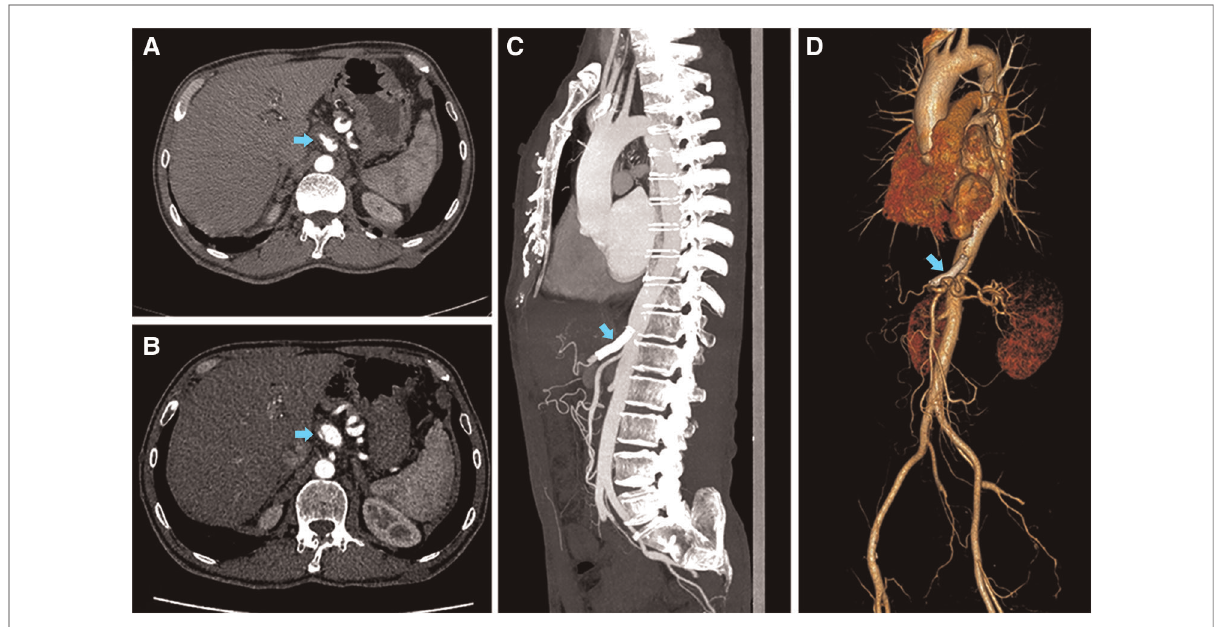
FIGURE 1 Imaging fi ndings of the therapeutic process for one patient for whom the conservative treatment failed. A 51-year-old Male with a complaint of abdominal pain for 1 day was diagnosed with symptomatic spontaneous isolated celiac artery dissection. ( A ) The imaging presented intramural hematoma accompanied by a penetrating ulcer. The patient was subjected to conservative treatment. ( B ) Three months after discharge, the patient had a symptomatic progression. The imaging showed the lesion had a severe extension with a visible dissection fl ap and narrow true lumen 3 months after discharge. The patient then underwent stent placement. ( C,D ) The stent was patent and the celiac artery had a complete remodeling with false lumen disappearance and true lumen recovery at the one-year follow-up after the secondary